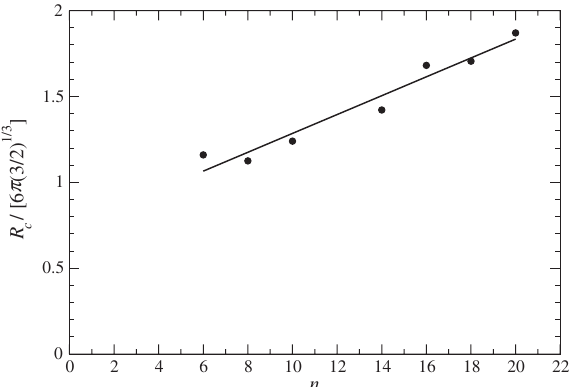
FIG. 6. Critical Reynolds number as a function of wave num- ber n (dark circles). The solid line is the linear fit